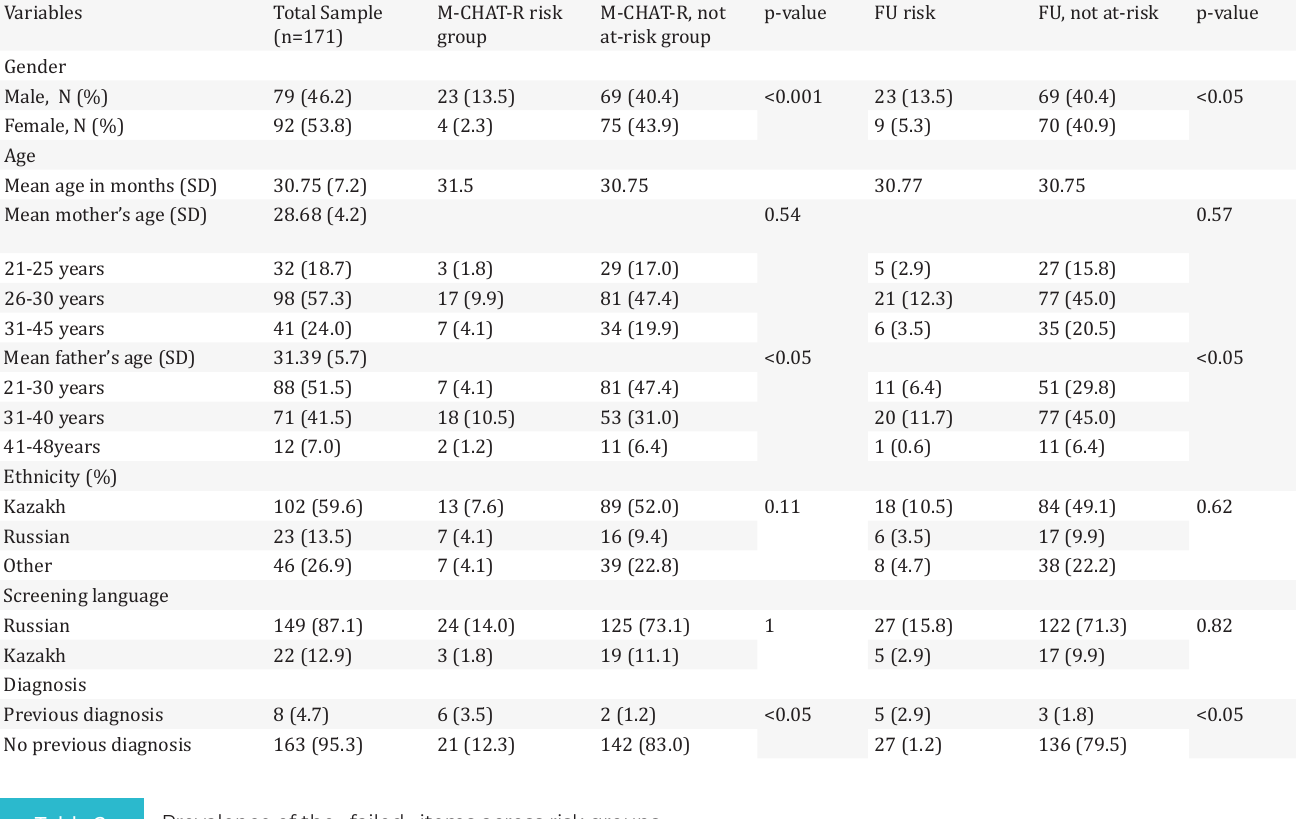
Prevalence of the «failed» items across risk